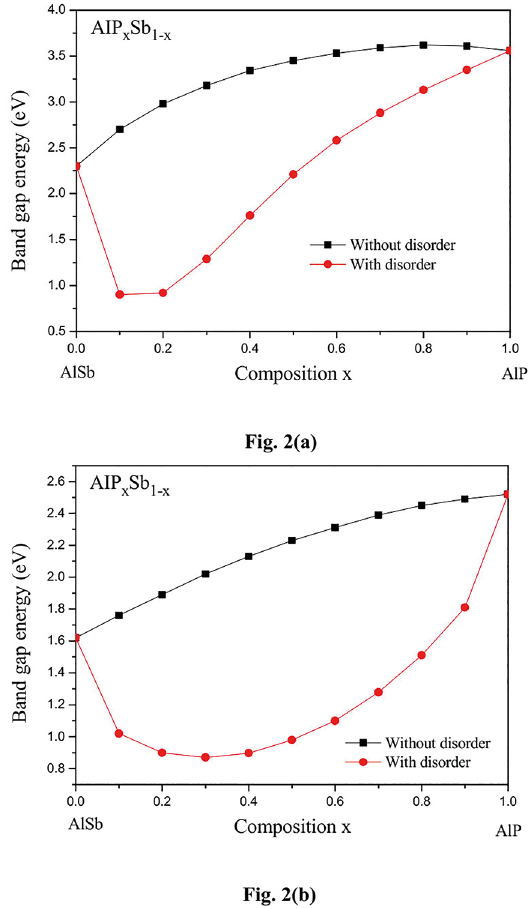
Sb ternary x 1-x